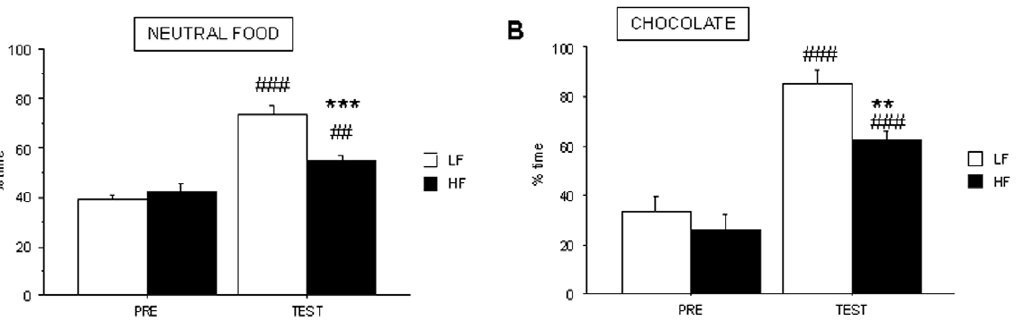
Figure 3. Conditioned-place preference induced by food in control and HF C57BL/6J mice. CPP was induced by a three-day schedule treatment with neutral food ( A ) or chocolate ( B ) pellets. Animals were tested during 30 min and results are expressed as % time spent in the white, food-paired, arm. Values are mean 6 S.E.M. of 12 animals for neutral food and 6–8 animals for chocolate (**p , 0.01 for comparison between control and HF groups, and ## p , 0.01, ### p , 0.001 for comparison between testing –TEST- and preconditioning –PRE- phases).